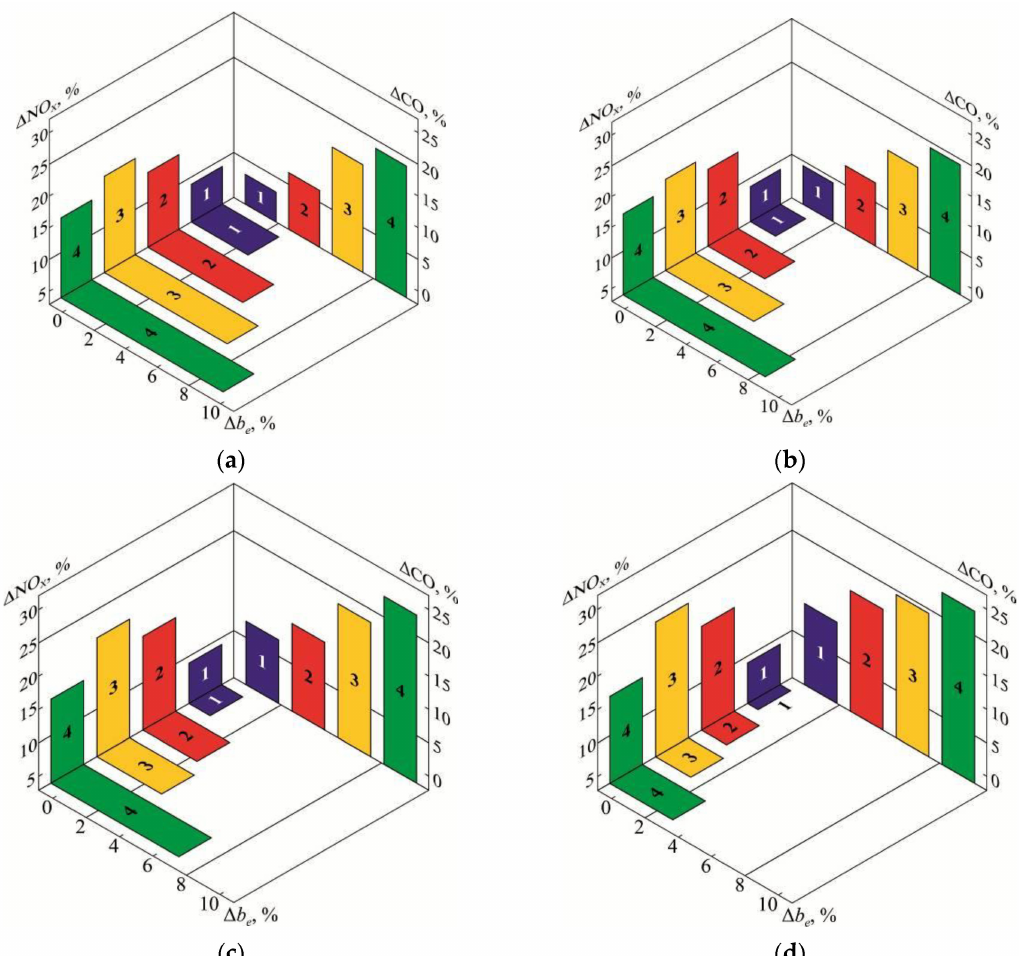
Figure 4. The performance variation of the 6N165LW Yanmar diesel engine when using different fuel blend: ( a )—load 50%; ( b )—load 60%; ( c )—load 70%; ( d )—load 80%; 1—RMA10 + 5% biofuel; 2—RMA10 + 10% biofuel; 3—RMA10 + 15% biofuel; 4—RMA10 + 20%